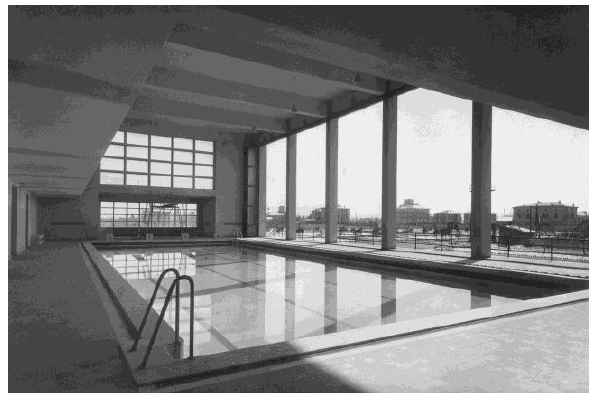
Figure 6. Casa del Balilla, internal view of the period.